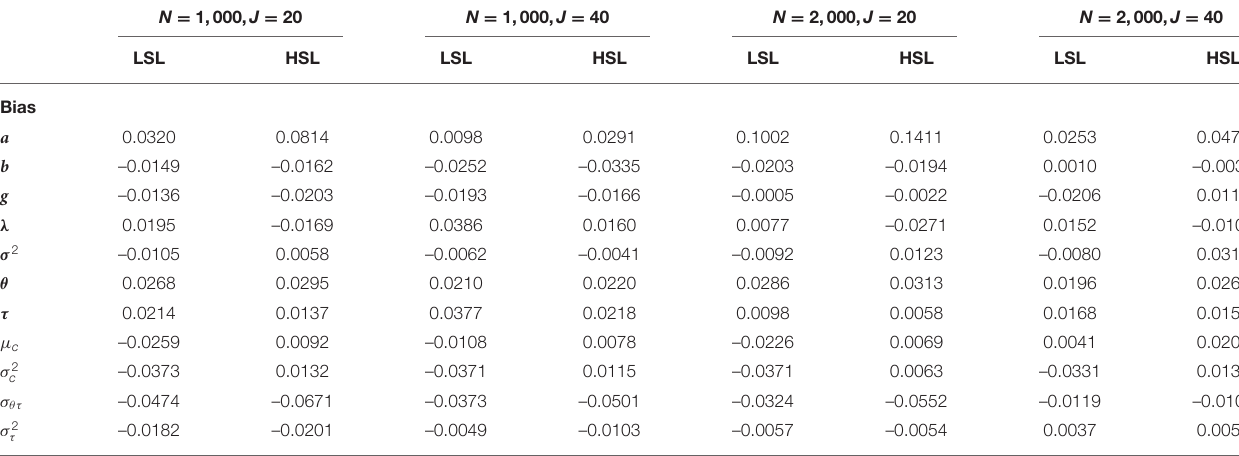
R for item parameters in the simulation study 1. FIGURE 6 | The trace plots of b TABLE 2 | Evaluating the accuracy of parameters based on mixture model in simulation study